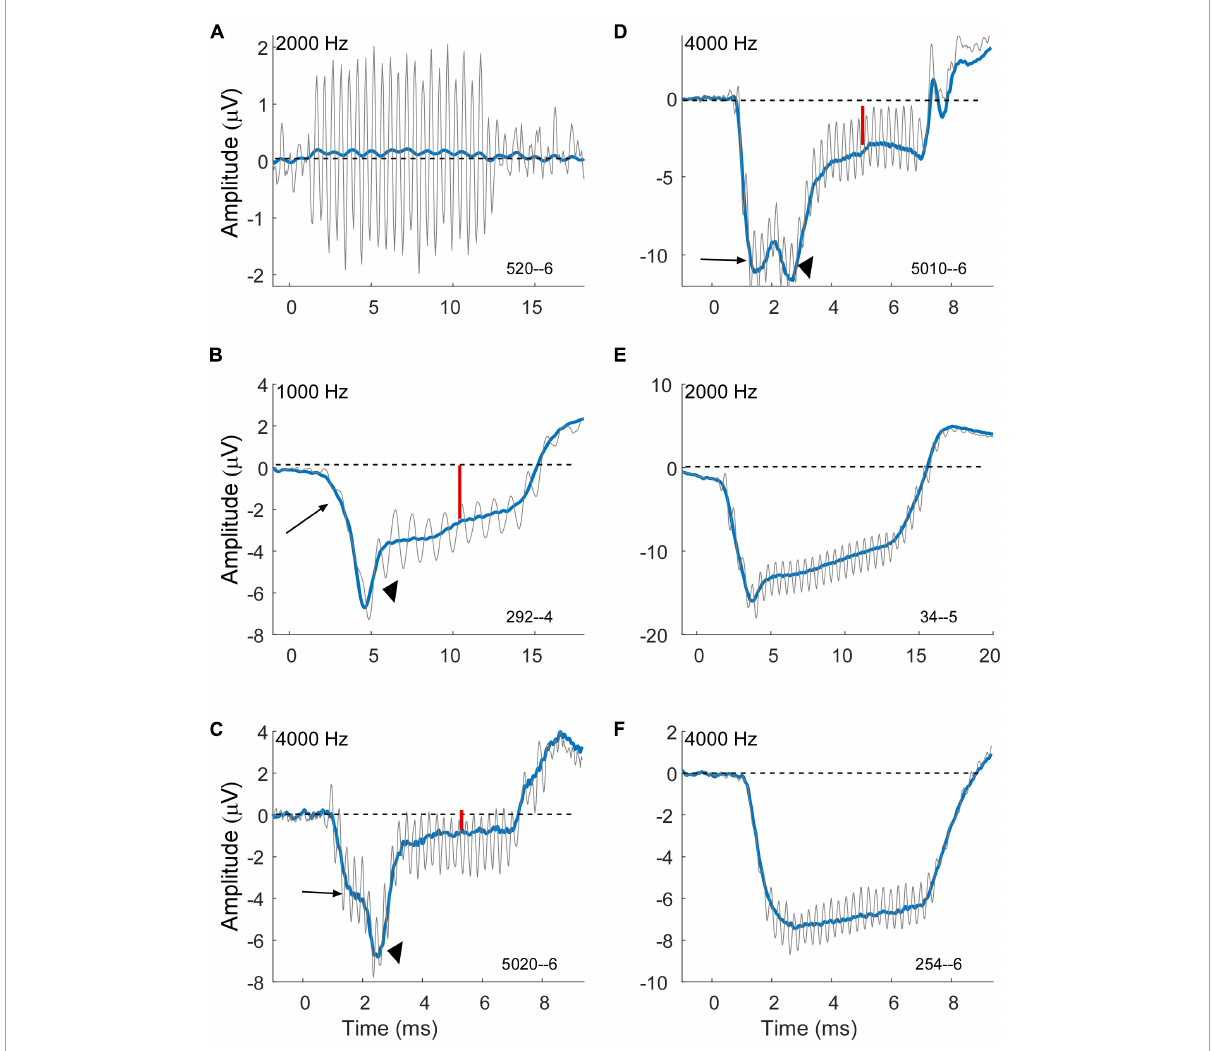
FIGURE6 Variability of compound action potential (CAP) and summating potential (SP) morphology in electrocochleography (ECochG) waveforms of subjects with Meniere’s disease (MD). Gray is the response to condensation phase and blue is the sum of the alternated phases. (A) Example of a case with a strong cochlear microphonic (CM) but essentially no SP, indicative of little or no asymmetry in the hair cell output and little or no neural response. (B–D) Example of cases showing an early SP (long arrows) due to outer hair cells, a CAP (arrowheads) indicating neural involvement, and a steady state SP (small red arrows) that are presumably the sum of outer hair cell (OHC), inner hair cell (IHC) and neural contributions. Each example shows a different morphology of the CAP. (E) Example of a case with an early SP from OHCs, no obvious CAP, and then a steady state SP that is presumably the combination of OHC and later-arriving IHC contributions. (F) Example of a case with an early SP from OHCs and little change thereafter, suggesting limited IHC and neural contributions. All cases were at 90 dB